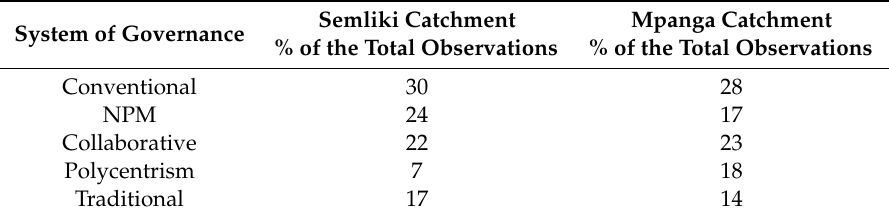
Table 2. Water resource systems of